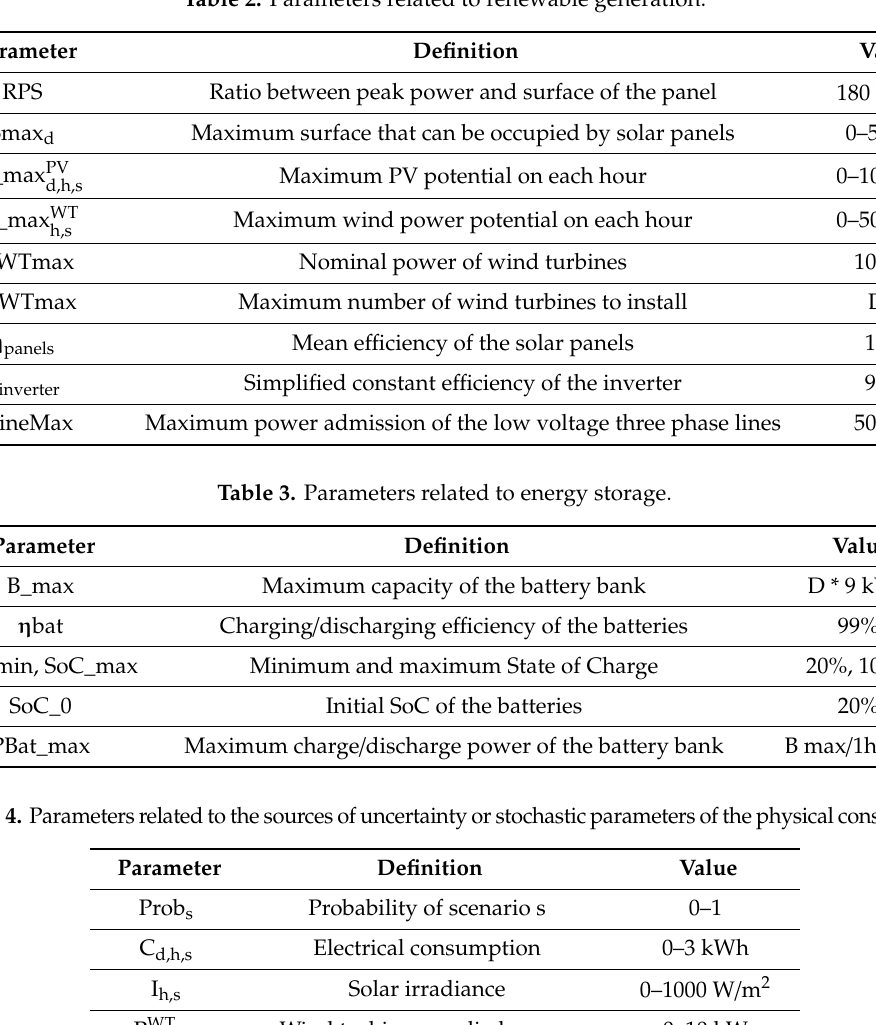
Table 2. Parameters related to renewable generation.